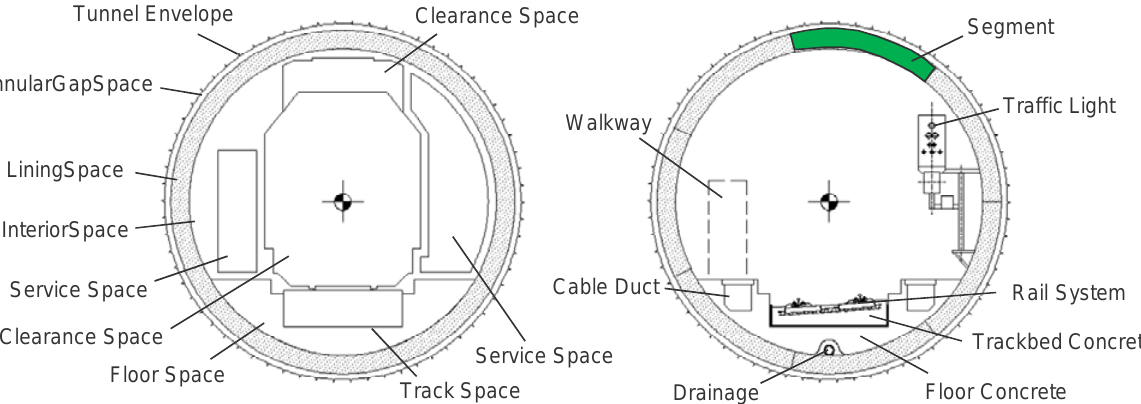
Figure 5. A tunnel cross-section showing the individual spaces (left) and elements (right) of the product